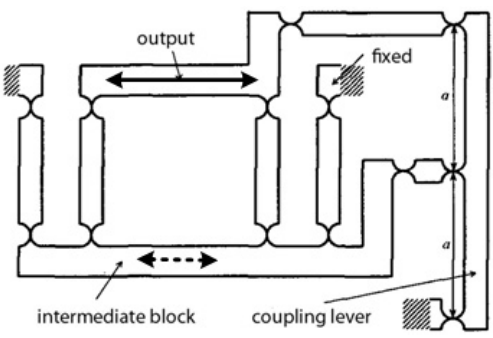
Figure 7. Sketch of the 13-hinge table